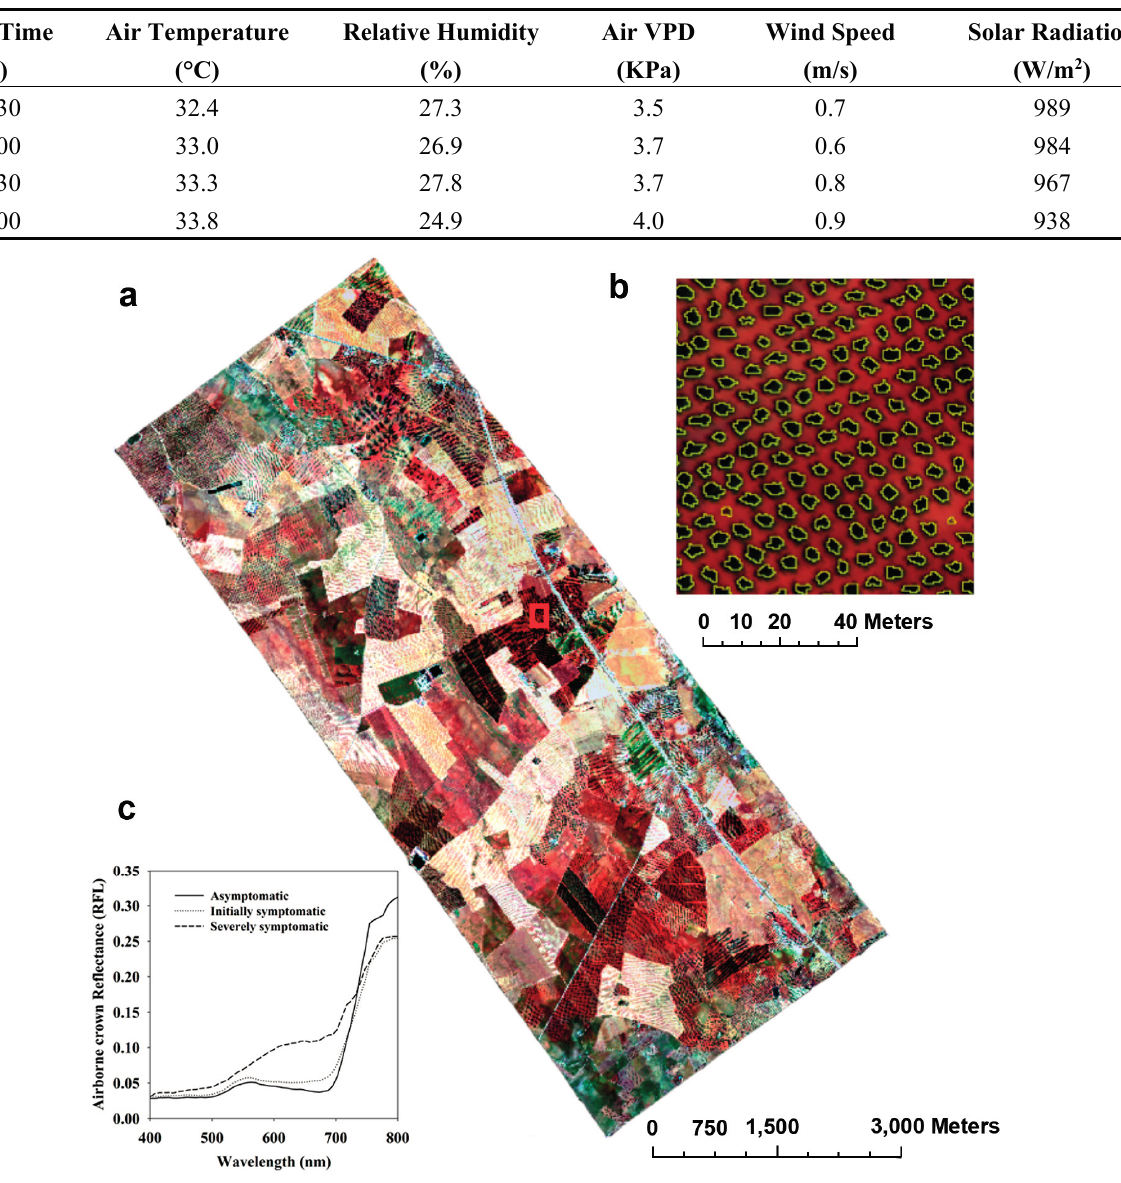
Figure 4. Hyperspectral mosaic ( a ) obtained with the hyperspectral sensor on board the manned platform at 50-cm resolution. Pure olive crowns were identified using automatic object-based crown detection ( b ). Sample crown reflectance obtained by the hyperspectral imagery from Verticillium wilt asymptomatic, initially symptomatic and severely symptomatic olive trees is shown in ( c ). Red square ( a ) is shown in detail in ( b